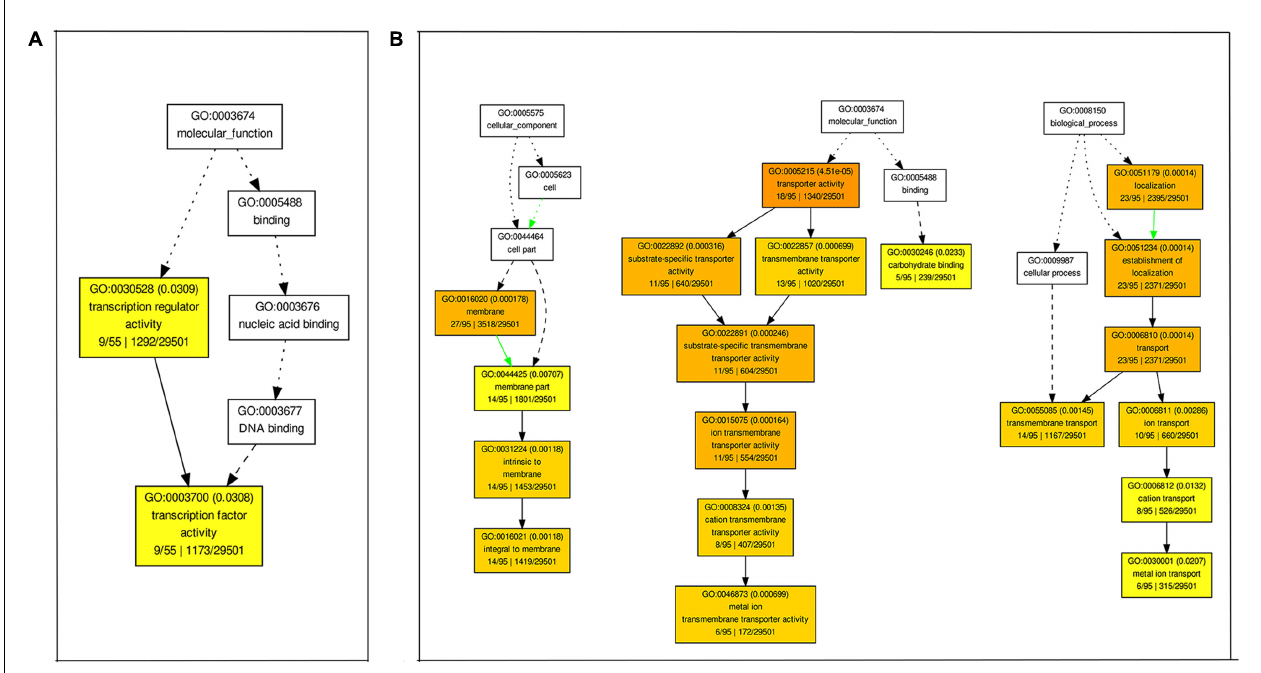
FIGURE 4 | Enriched Gene ontology (GO) terms for up-regulated genes at 12 h (A) and 24 h (B) after 90 mM NaHCO 3 (pH = 8.5) stress. The Singular Enrichment Analysis (SEA) was carried out by agriGO. The GO terms with their IDs are written in boxes. The significant ( P < 0.01, FDR < 0.05) GO terms are in colored boxes (the degree of color saturation is positively correlated to the enrichment level of the GO term), and non-significant terms are in white